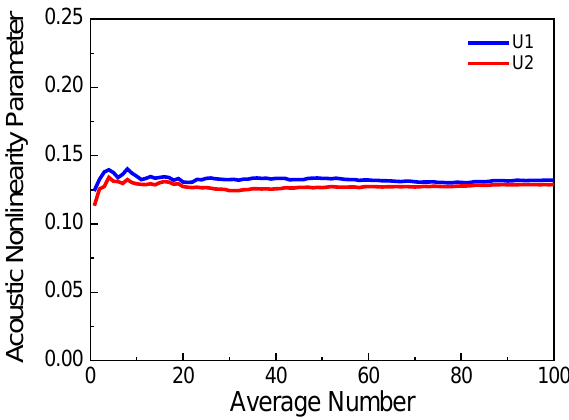
Figure 3. Acoustic nonlinearity parameter versus number of FEM models ( c = 0.1, f = 1000 kHz, µ = 0.1, % = 60%).